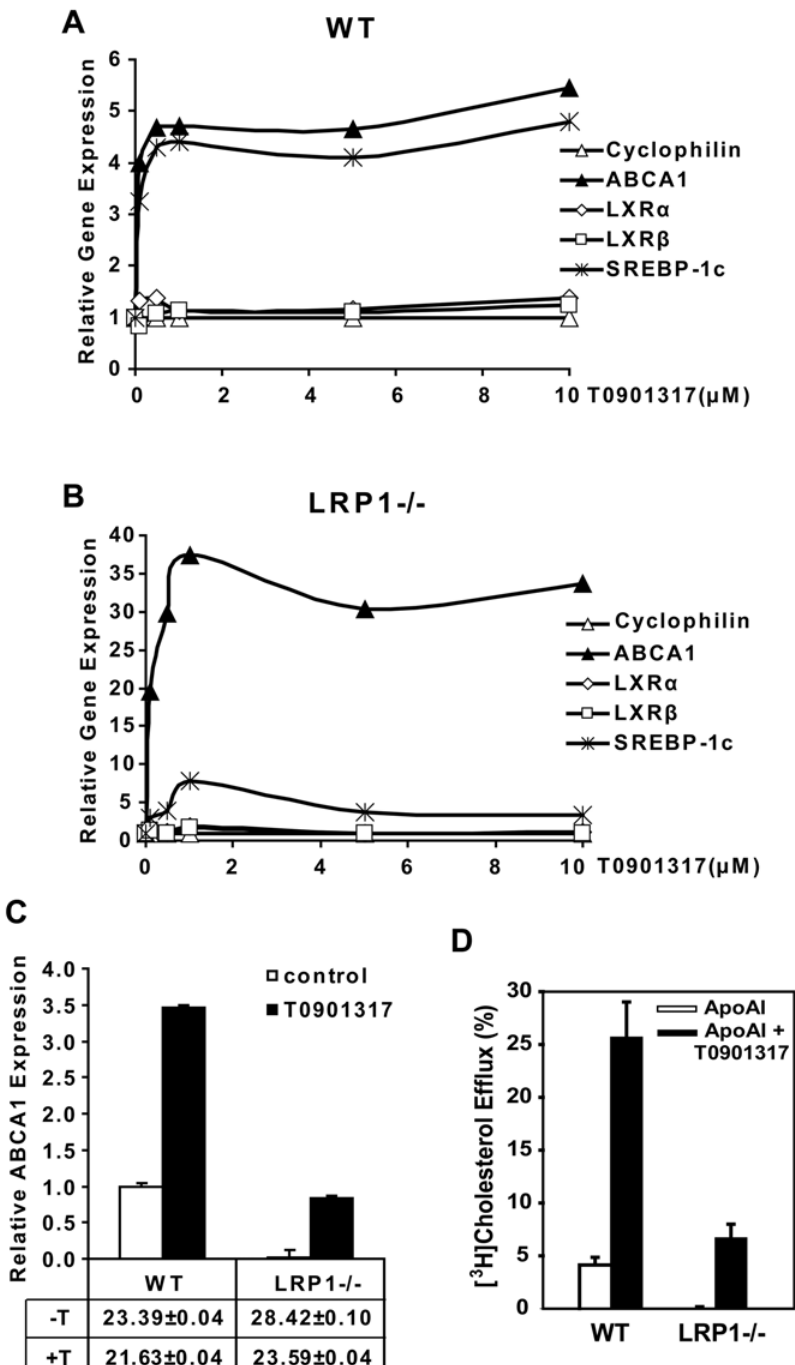
Figure 6. T0901317, a synthetic agonist of LXRs, up-regulates the expression of ABCA1. A&B . Concentration-response curves of T0901317. WT (A) and LRP1 2 / 2 (B) SMCs were treated with the indicated concentrations of T0901317 for 48 h and mRNA levels of ABCA1 and LXRs was subsequently determined by real-time PCR. Cyclophilin was used for normalization and SREBP-1c, a known LXR-regulatory gene [49], was added as a positive control. T0901317 up-regulated ABCA1 transcription at a low concentration of 0.1 m M and reached its maximum effect at approximately 1 m M in the absence or presence of LRP1. C . RT-PCR analysis of ABCA1 expression in WT and LRP 2 / 2 SMCs treated for 24 h with 5 m M T0901317. C T values in the absence ( 2 T) and presence ( + T) of the LXR agonist are shown 6 S.D. Treatment of LRP 2 / 2 SMCs with LXR agonist restored ABCA1 mRNA expression to wild type levels. Assays were performed in triplicate, standard deviations are shown. D . ApoAI-mediated cholesterol efflux was analyzed both in WT (white bars) and LRP1 2 / 2 (black bars) SMCs in the presence and absence of T0901317 using [ 3 H]-labeled cholesterol. Radioactivity released from the cell into the medium was measured by liquid scintillation counting, and cellular lipids were extracted and analyzed for [ 3 H]-sterol. Data are expressed as percentage of total (cell plus medium) [ 3 H]-sterol released into the medium. A significant increase in apoAI- mediated cholesterol efflux was observed in both cell lines in the presence of T0901317. ApoAI-mediated cholesterol efflux was barely detectable in the LRP1 2 / 2 SMCs in the absence of prior T0901317 stimulation. The assay was performed in quadruplicate, and values are expressed as mean 6 S.D.